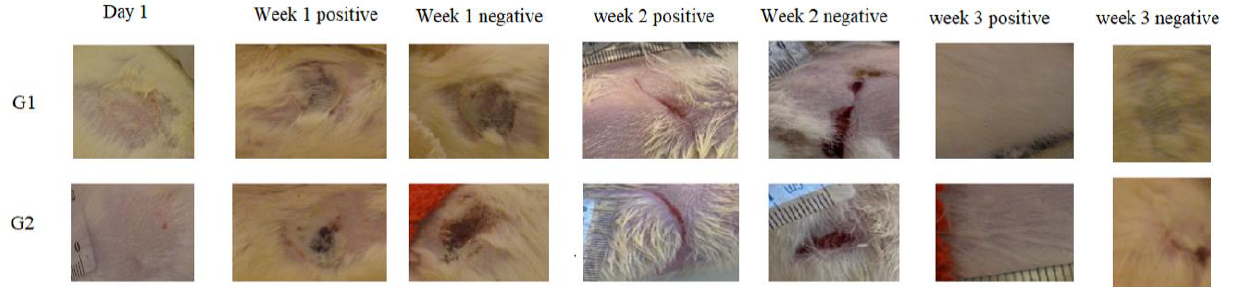
Figure 3. Morphological appearances of Artemisia judaica (G1)- and silver sulfadiazine (SS) (G2)-treated wounds at various time points.